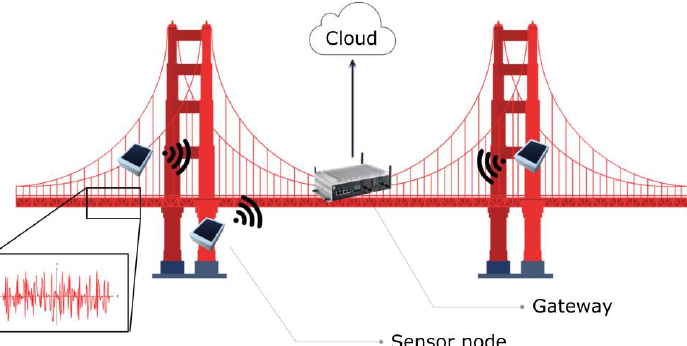
Figure 1. Schematization of the monitoring system to be mounted on the structure.